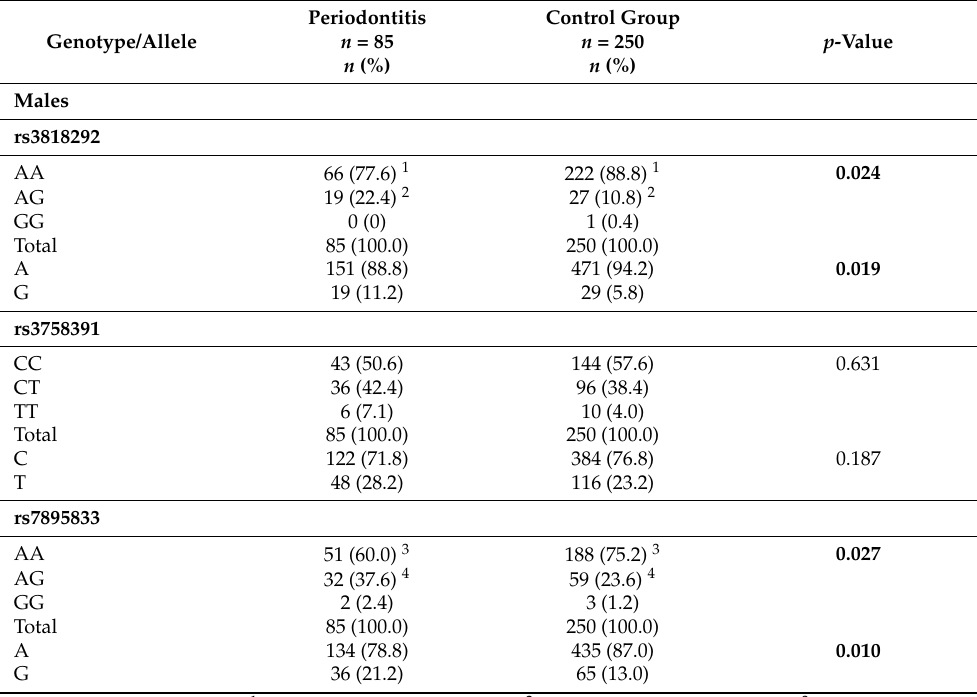
Table 4. Genotype and allele distribution of SIRT1 rs3818292, rs3758391, and rs7895833 in periodonti- tis and control groups between males.